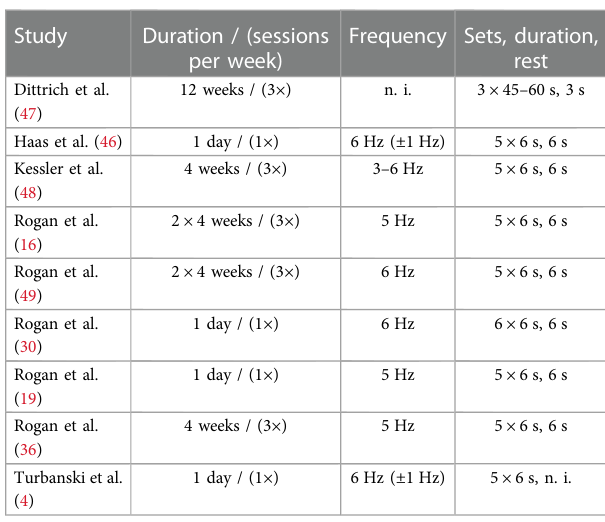
TABLE 2 SR-WBV training load as used in the different studies under